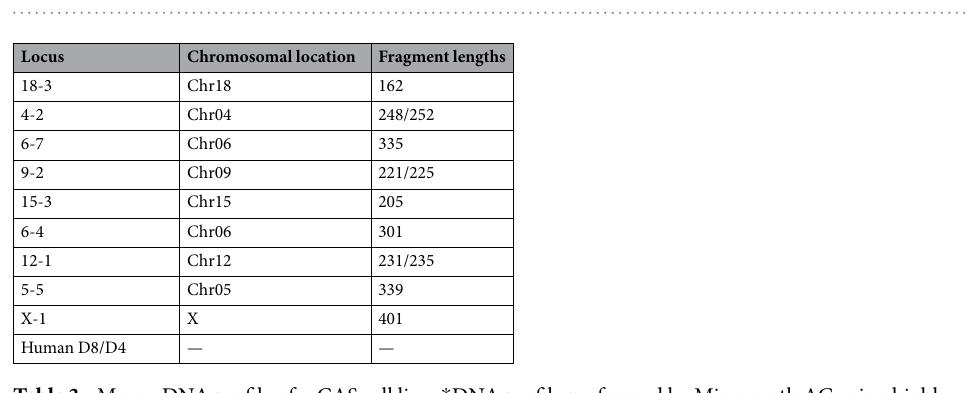
Figure 4. Mouse DNA profiling of e-CAS cells. The figure shows the electropherogram obtained from the DNA profiling of e-CAS cells. 9 murine markers were positively identified in the assay. Possible contamination with another mouse or human cell line was discarded.